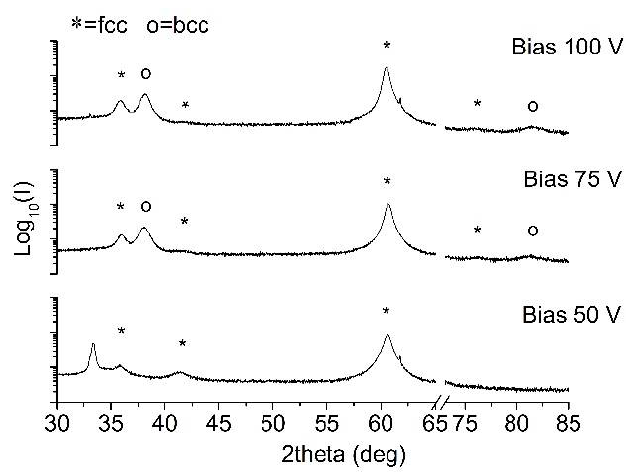
Figure 5. XRD patterns of TaAlN films deposited at different bias voltages. Table 2. Microstructure parameters estimated from XRD